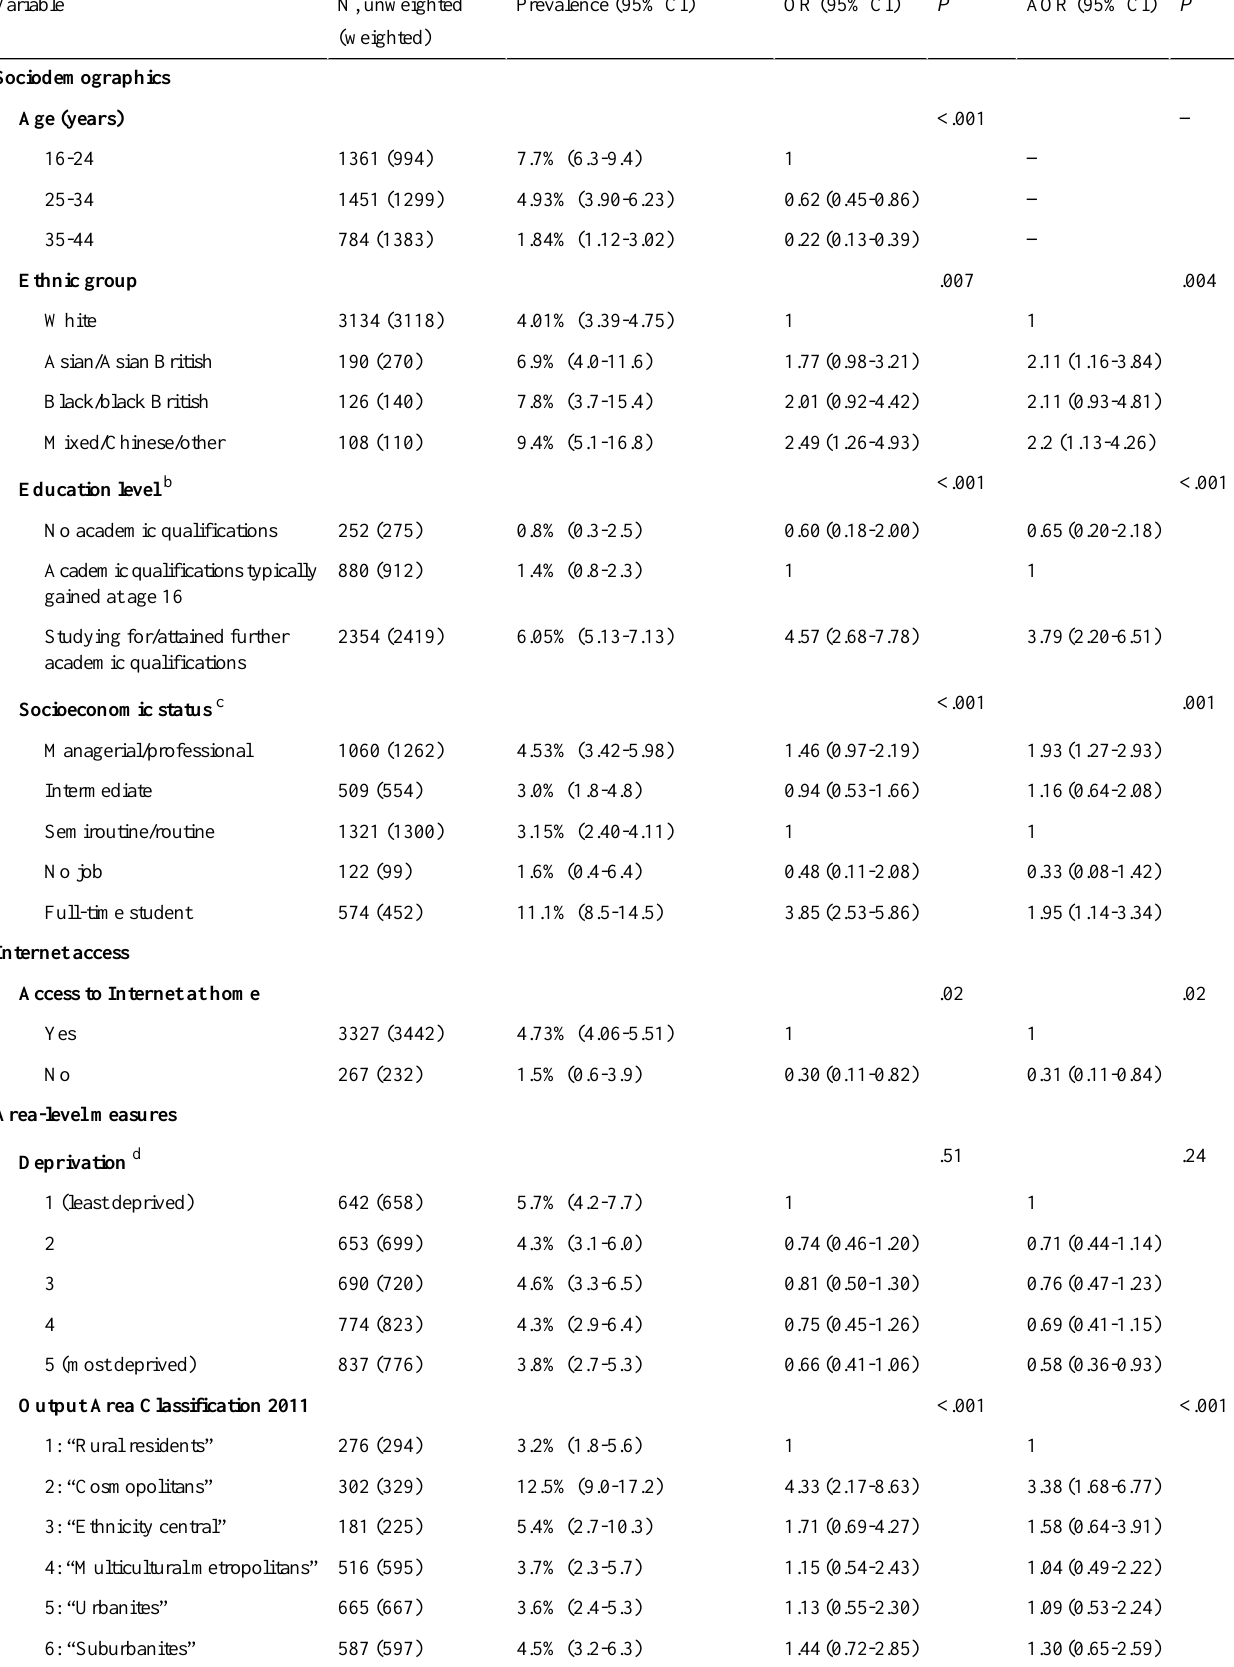
Table 3. Variation in the prevalence and odds of reporting recent (past year) use of information/support websites for advice/help with one’s sex life (Internet information/support) among sexually experienced men aged 16 to 44 years.